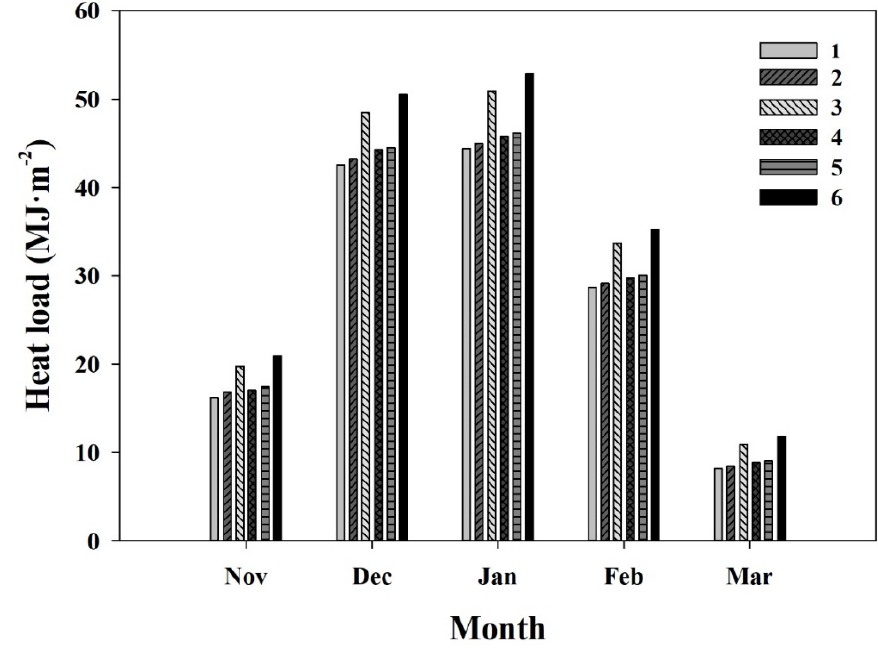
Figure 13. Monthly heating load of greenhouse using different thermal screens. Table 6. Detail of Figure 13.